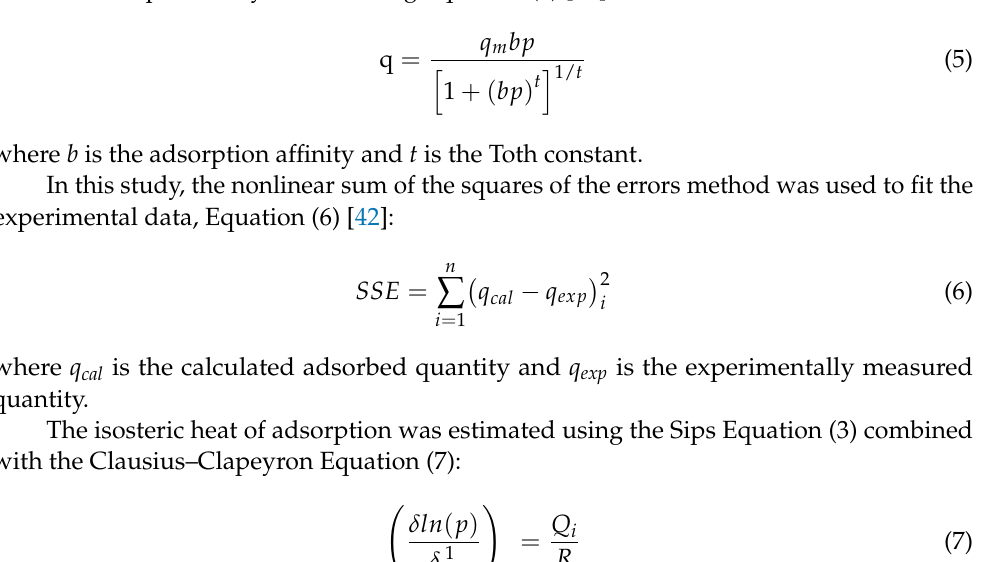
Supplementary Materials: The following are available online, Figure S1: Results from mass spec-